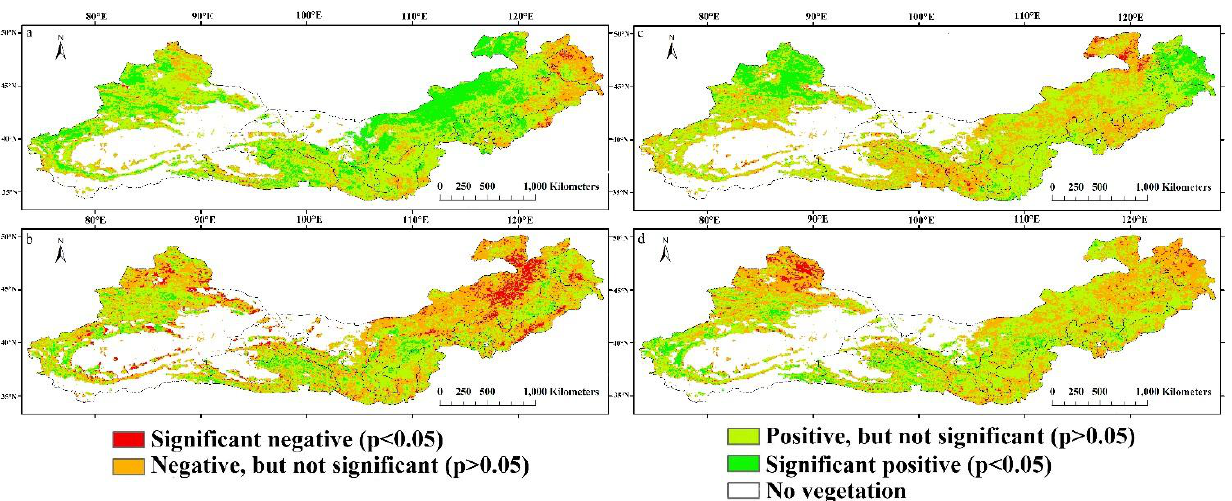
Figure 5. Correlations between growing-season NDVI and ( a ) corresponding precipitation, ( b ) corresponding temperature, ( c ) pre-growing season precipitation, and ( d ) temperature from 1982 to 2011. Correlations were considered significant for p < 0.05. Red areas represent negative relationships, and green areas represent positive